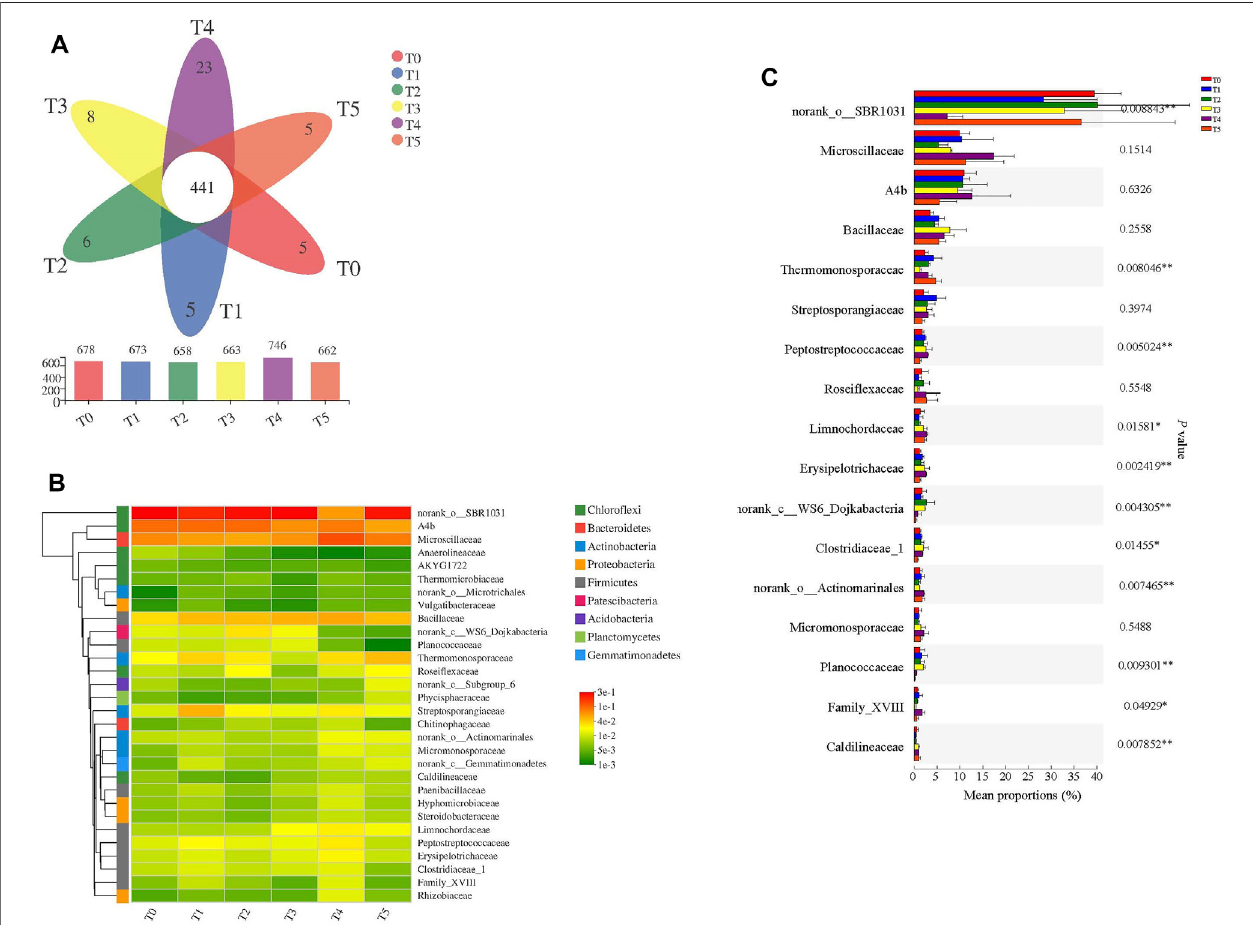
FIGURE2| Effectsofantibiotictypeonbacterialcommunitystructureinsixdifferenttreatmentsinswinemanurecomposting.In (A) theVenndiagramatthephylum level;in (B) theheatmapofspeciescompositionatthefamilylevel,andin (C) thesigni fi canceanalysisofdifferencesatthefamilylevelamongthetreatments.Comparison of Bacterial Composition at the Family Level among the